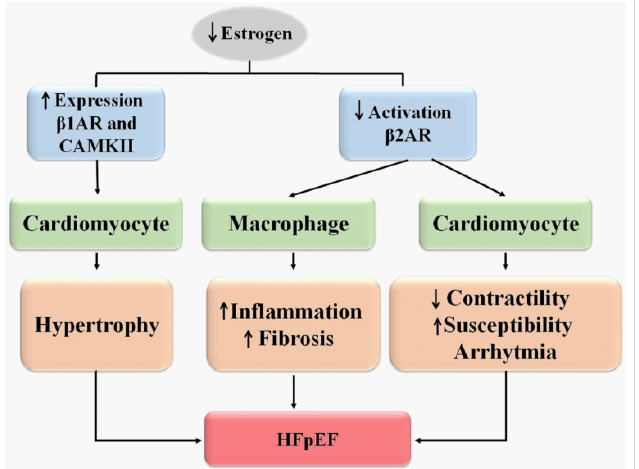
Figure 3. Estrogen depletion modulating beta-adrenergic receptors. β 1AR—beta 1 adrenergic recep- tors; β2AR —beta 2 adrenergic receptors; HFpEF—heart failure with preserved ejection fraction.